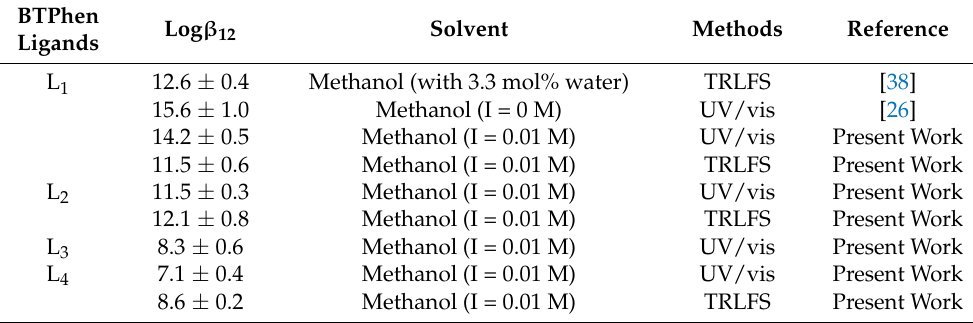
Table 2. Conditional stability constants of BTPhen ligands with